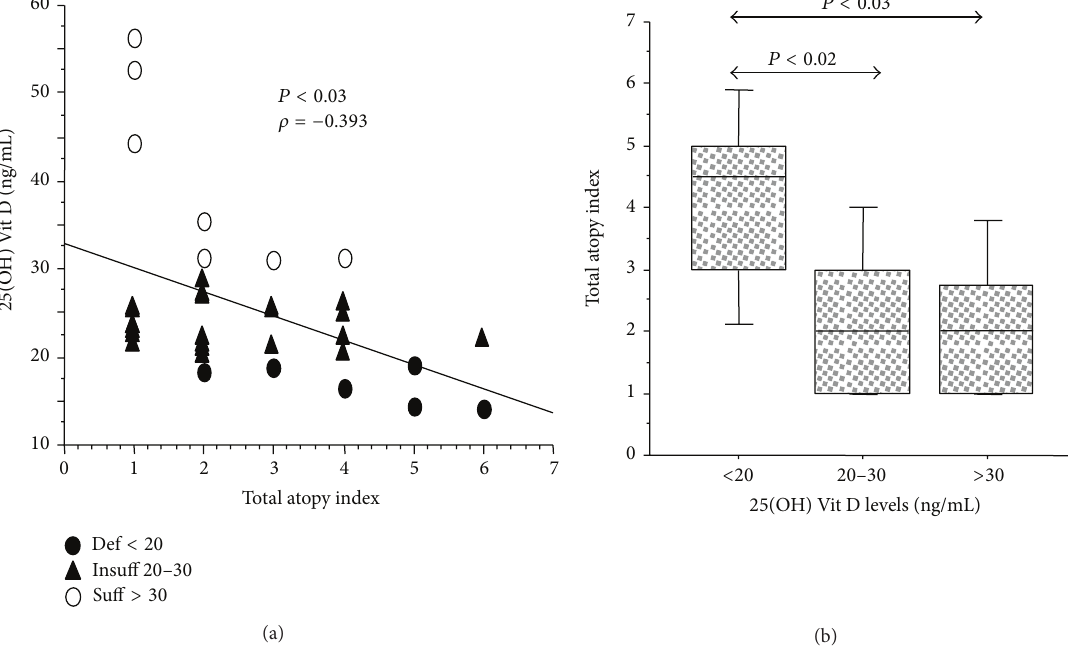
Figure 6: Relationship between 25(OH) Vit D plasma levels and total atopy index in patients with AAR ( 𝑛 = 35 ). (a) 25(OH) Vit D levels and total atopy index inversely correlated in AAR patients. Statistical analysis was performed by Spearman rank test; (b) total atopy index in AAR patients with deficient ( 𝑛 = 6 ), insufficient ( 𝑛 = 22 ), or sufficient ( 𝑛 = 7 ) 25(OH) Vit D levels. Bars in the box plots indicate (from the bottom to the top) 10th, 25th, 50th (median), 75th, and 90th percentiles. Statistical analysis was performed by Kruskal-Wallis test and Mann-Whitney U test. Significance was accepted at 𝑃 < 0.05